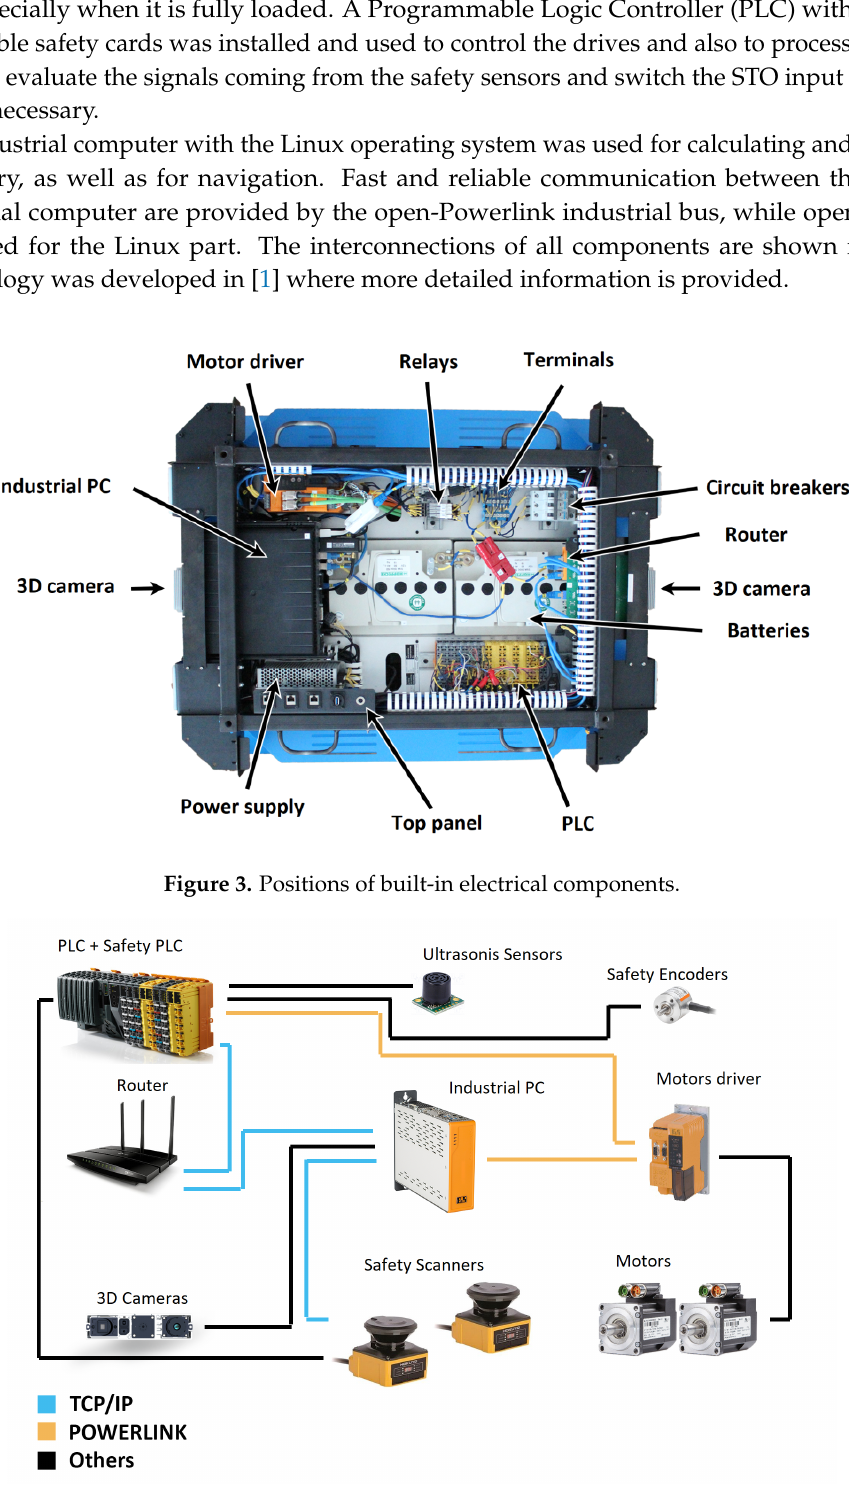
Figure 4. Interconnections between all electrical components in